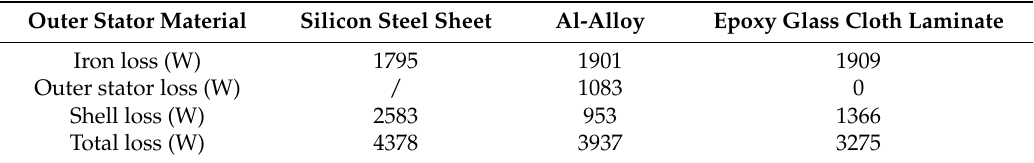
Table 5. Losses of stator with different materials of outer stator.